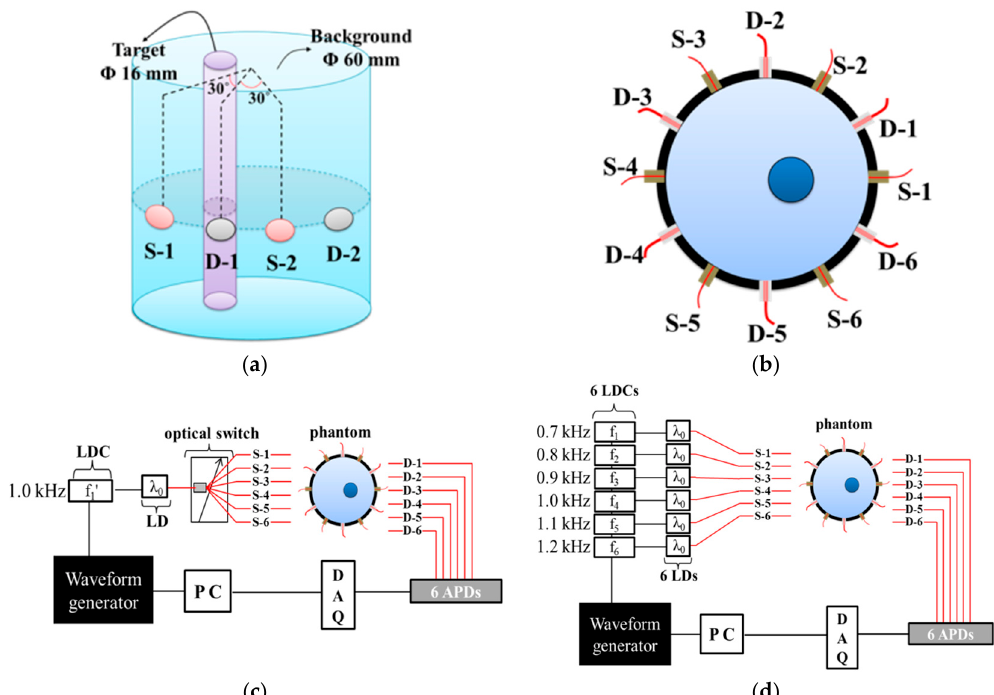
Figure 1. Schematic diagrams of ( a ) the cylindrical phantom and ( b ) the S-D interface configuration, block diagrams of experimental setups for ( c ) the time-division multiplexing (TDM) diffuse optical tomography (DOT) system and ( d ) the frequency-division multiplexing (FDM) DOT system; “LDC”, “LD”, and “DAQ” are acronyms for “laser diode controller”, “laser diode”, and “data acquisition system”, respectively.